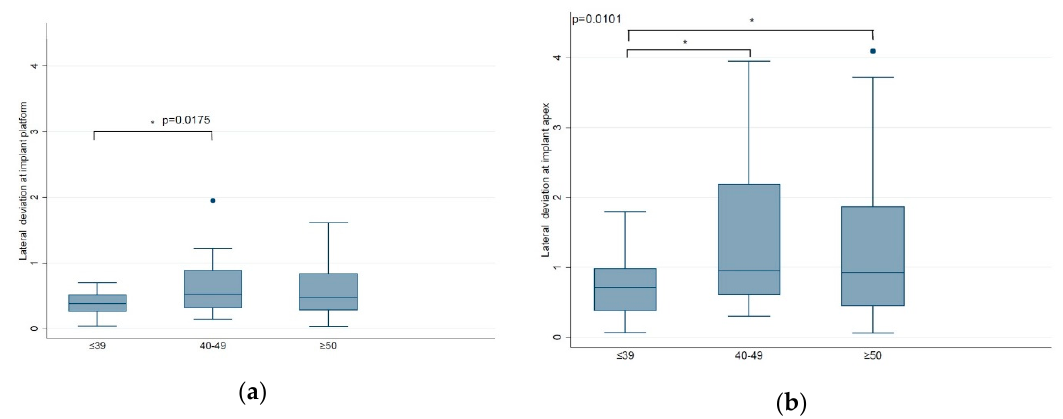
Figure 11. Box plots of the lateral deviation at the implant: ( a ) platform and ( b ) apex of the three operator age groups.